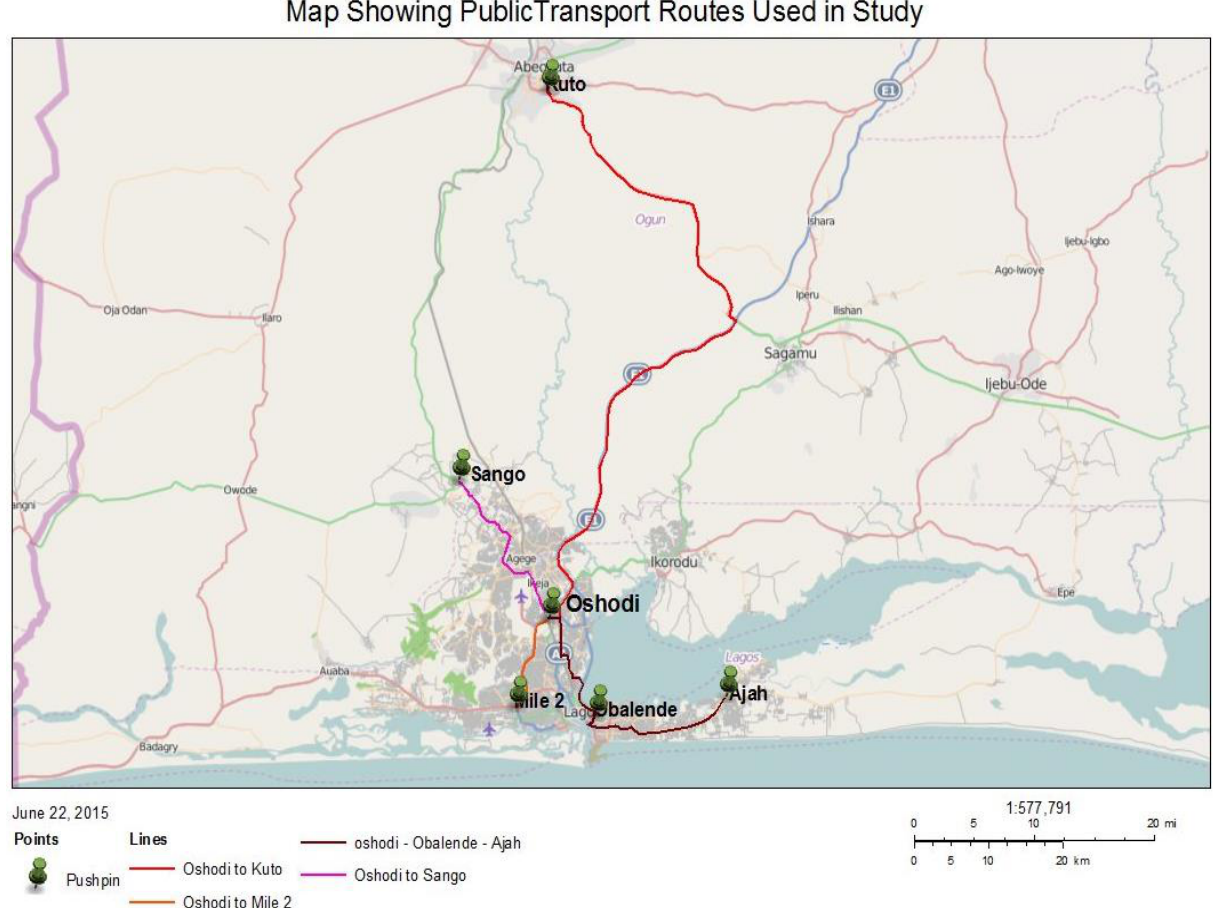
Fig. 1. Map showing public transport routes used in